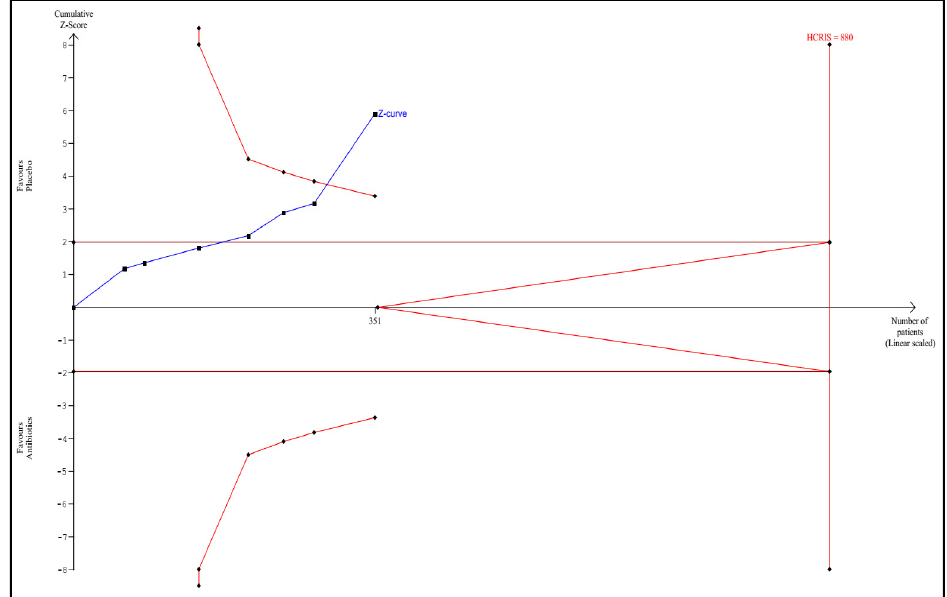
Figure 9. Trial sequential analysis for the length of hospital stay. The HCRIS was 880 patients based on a minimal relevant shortening of hospitalization of 2 days, an empirical variance of 112, and a heterogeneity of 0%. At 351 patients randomized (40% of the HCRIS), the Z-curve crossed both the conventional and sequential monitoring boundaries; HCRIS = heterogeneity-corrected required information size.